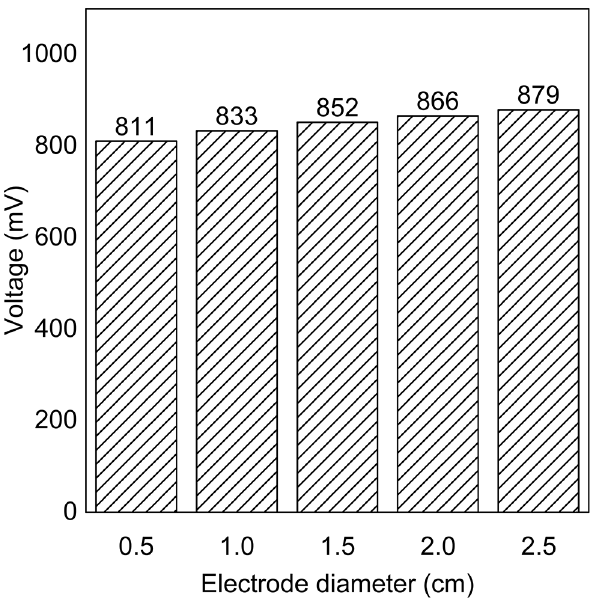
Fig 7. Voltages recorded in the second additional experiment. The electrode with the largest diameter obtained the highest